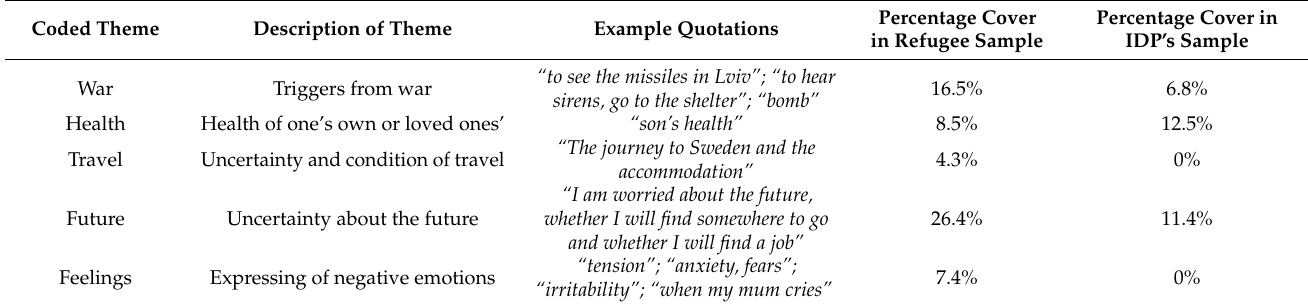
Table 3. Themes for the question “what worries you the most?”.